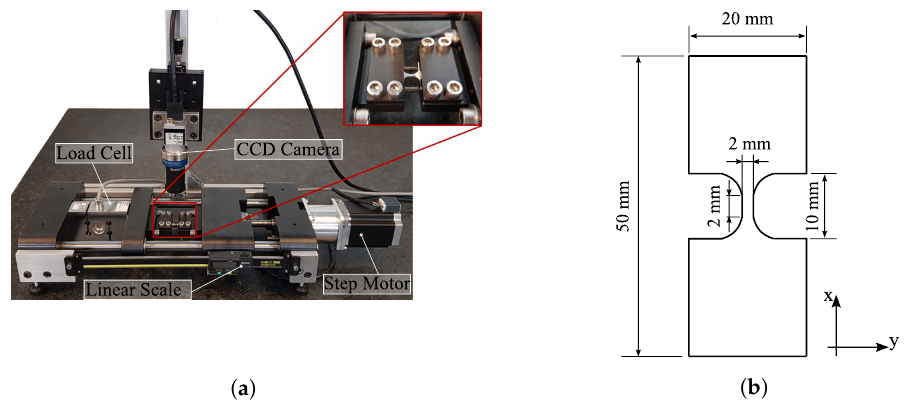
Figure 2. Miniaturized Specimen Tester Device (MSTD): ( a ) setup, and; ( b ) geometry of the miniatur- ized